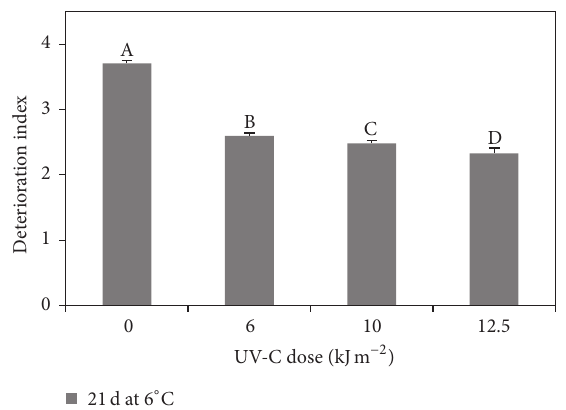
Figure 1: Deterioration index (DI) in carambola slices treated with 0 (control), 6, 10, or 12.5 kJ m −2 of UV-C radiation and stored for 21 days at 4 ∘ C. Bars represent the standard error ( 𝑛 = 3 ). Different letters indicate significant differences on Fisher’s test ( 𝑃 < 0.05